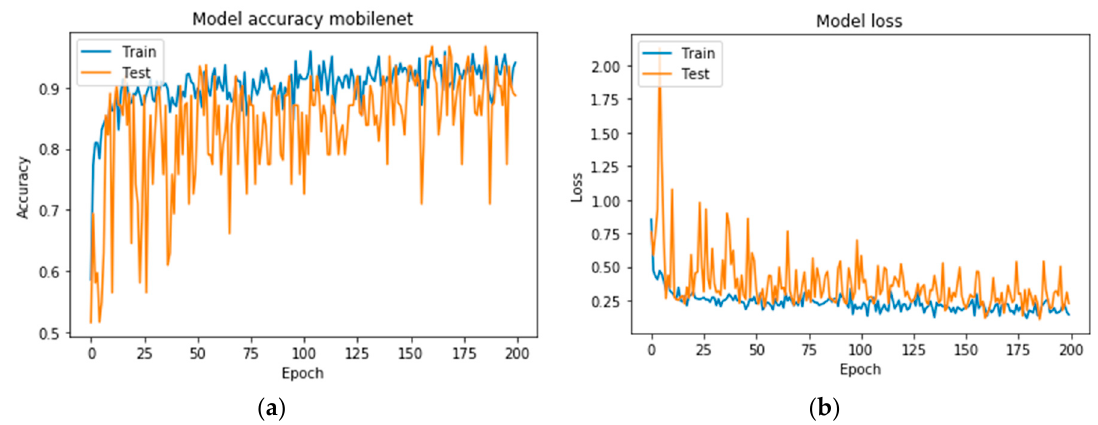
Figure A4. Precision curves for MobileNet ( a ) accuracy and ( b ) loss.